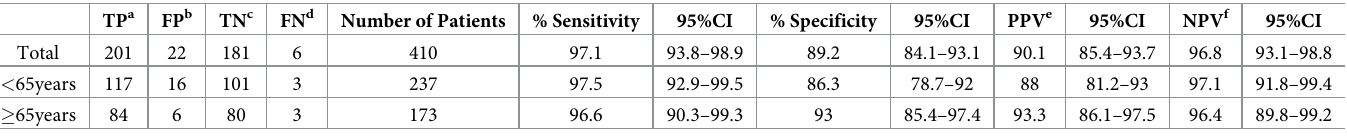
(Table 2). Among elderly patients of � 65 years of age, the sensitivity and specificity of ImunoAce Flu for influenza A virus were 96.6% (95%CI: 90.3–99.3) and 93% (95%CI: 85.4–97.4), respectively. In contrast, in adults of < 65 years of age, the sensitivity and specificity were 97.5% (95%CI: